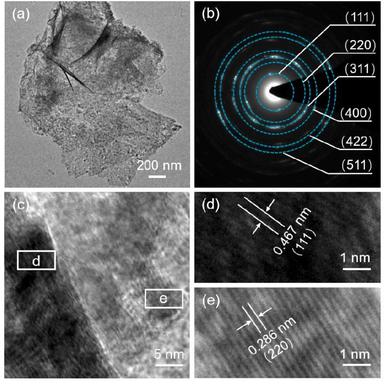
(a) TEM image, (b) SAED pattern, and (c-e) HRTEM images of MnCo2O4.5 nanosheets.